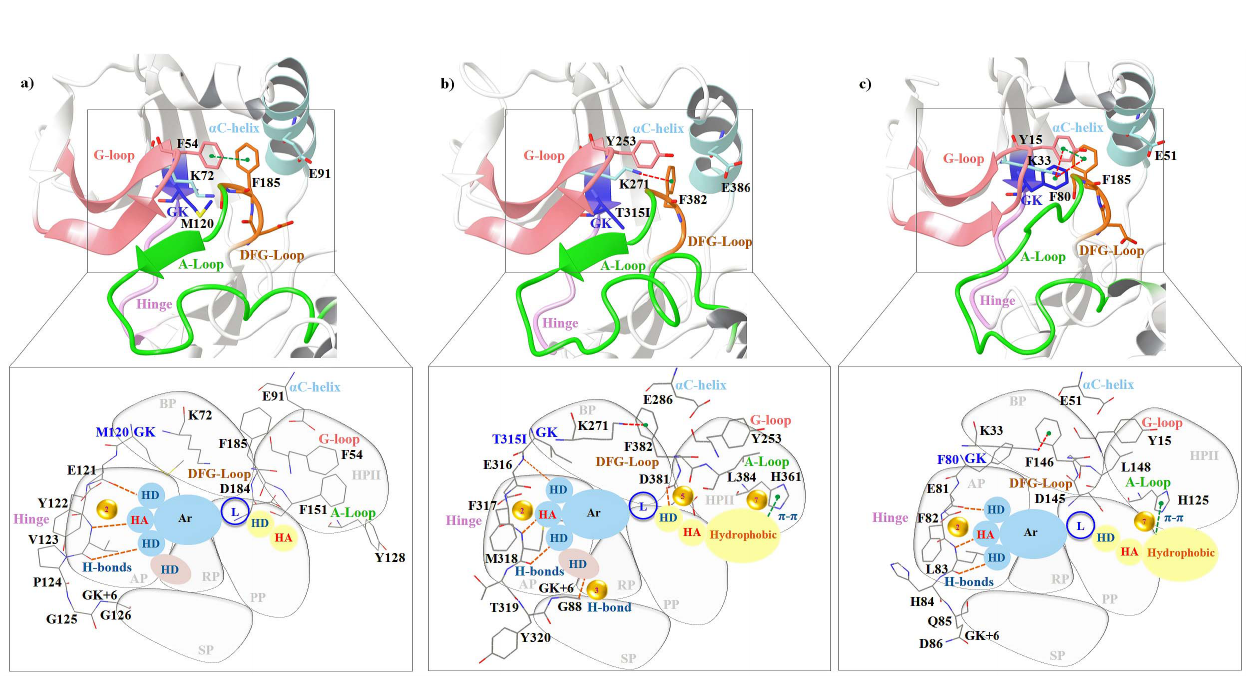
Figure 6. Comparative analysis of the specificity hot-spots explored by AK inhibitor in other kinases. Three kinases a) PKA b) ABL and c) CDK identified as potent co-targets for AK inhibitors have been modelled in the DFG-out (up) conformation. The six AK sub-pockets and its pharmacophore features have been overlapped on the binding-sites of three kinases. The inset shows the influence of the key-residues of different kinases on the binding of AK inhibitors as well as the likely sub-sets of AK specificity rendering sites and non-covalent interactions compatible to other